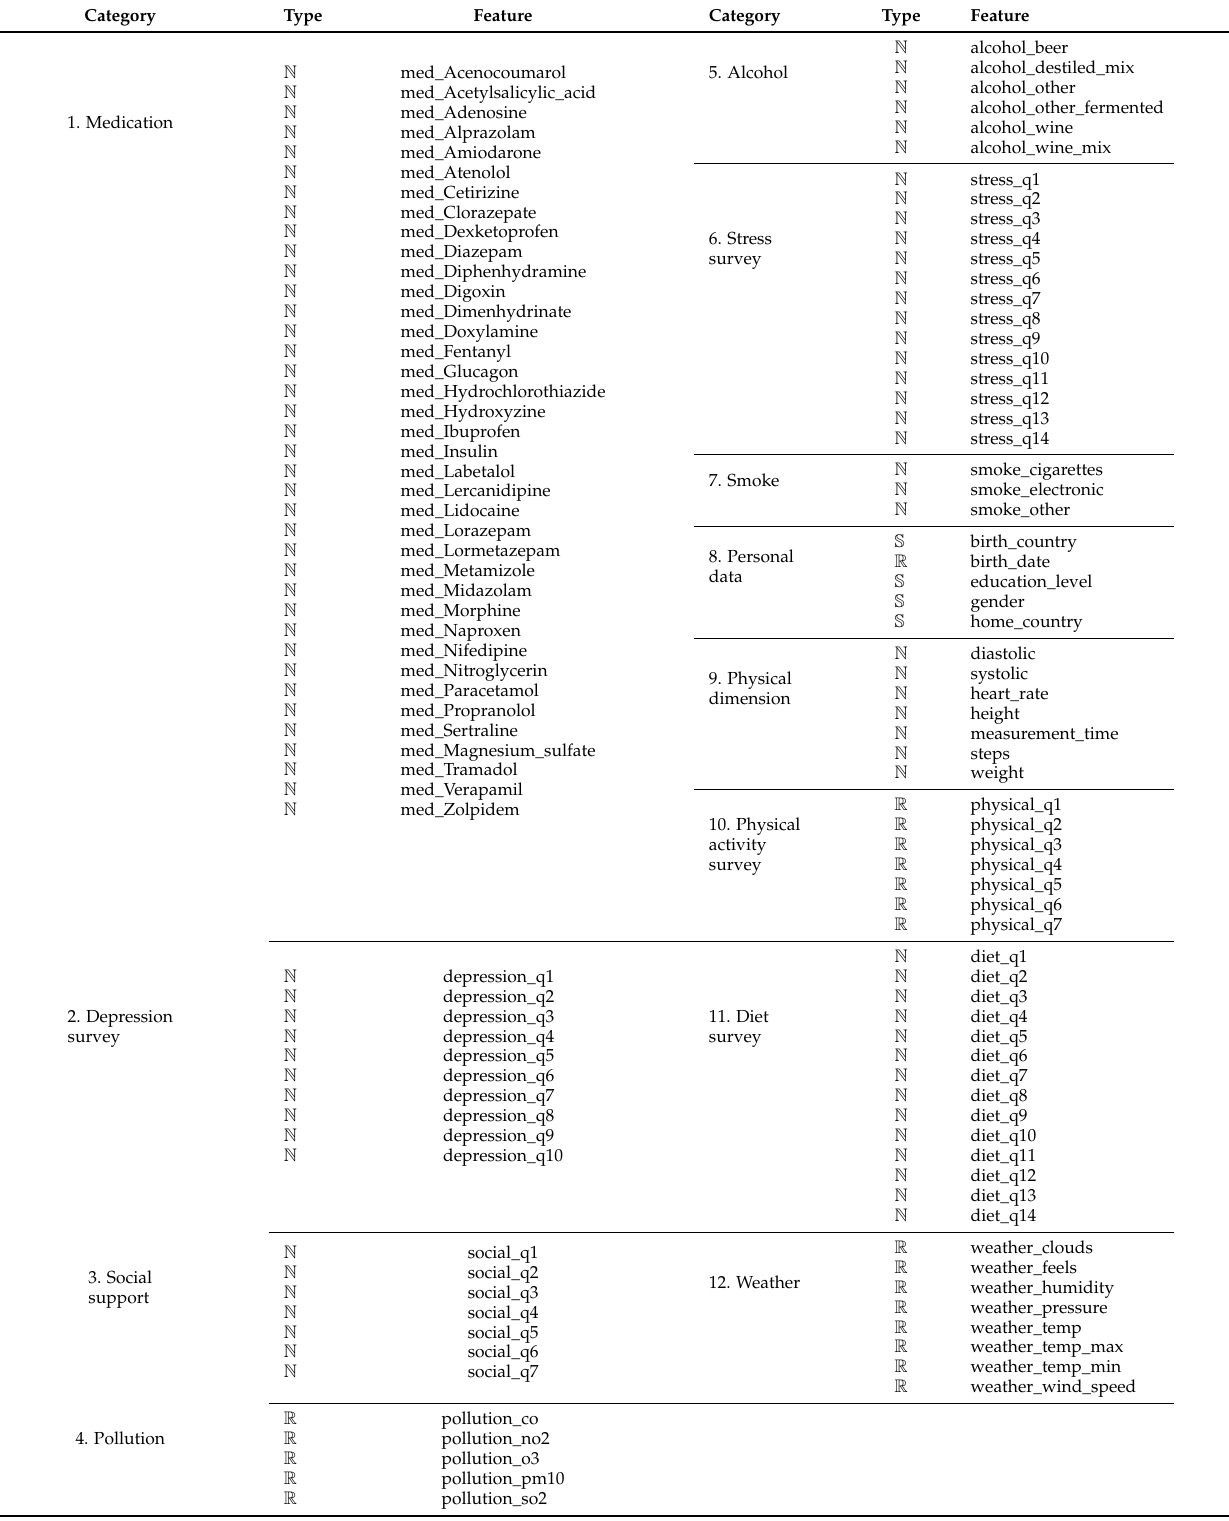
values selected for most relevant parameters used for each algorithm. The optimal number of iterations to search for the best combination is 100, selecting between these models the one offering best results. Table 2. List of features considered by SENIOR grouped by